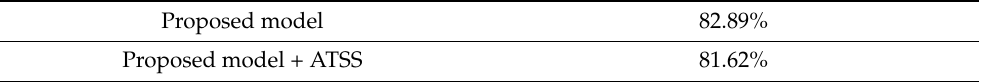
Table 4. Comparison of mAP values of the proposed matching strategy with ATSS on public dataset.